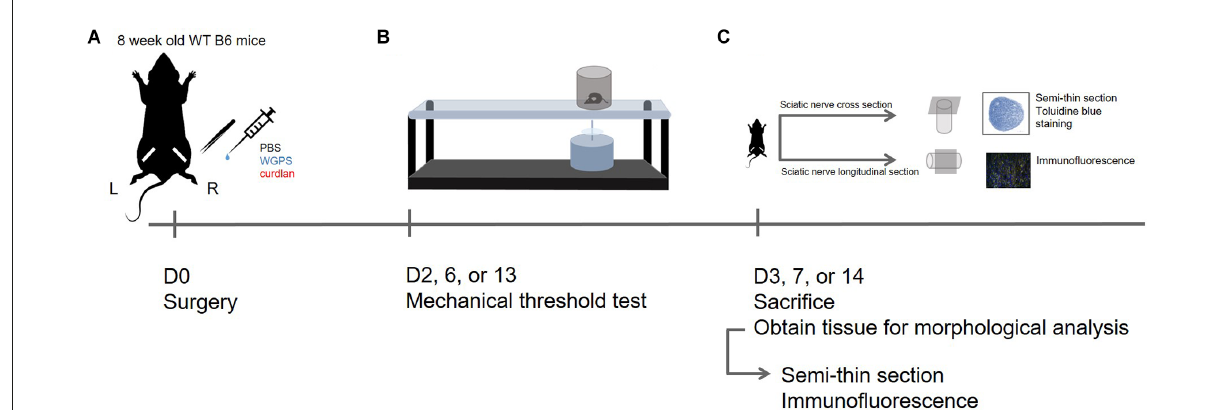
FIGURE1 Experimental design in this study. (A) D0: Sham surgery was performed on the left sciatic nerve; sciatic nerve crush surgery and injection of PBS (vehicle control), WGPS (Dectin-1 antagonist), or curdlan (Dectin-1 agonist) was performed on the right sciatic nerve. (B) D2, 6, or 13: Mechanical threshold test was performed to assess functional recovery. (C) D3, 7, or 14: The animals were sacrificed to obtain sciatic nerves for morphology analysis. Semi-thin sciatic nerve cross-sections were stained with toluidine blue to assess myelinated nerve and blood vessel profile; immunofluorescence staining was done on longitudinal sections of the sciatic nerve to assess Dectin-1 expression and macrophage density.